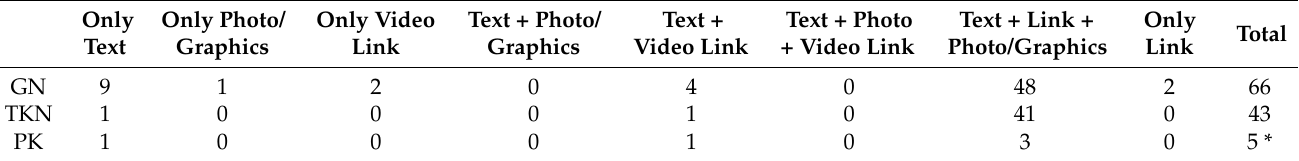
Table 7. Form of posts published on TT (N = 114).